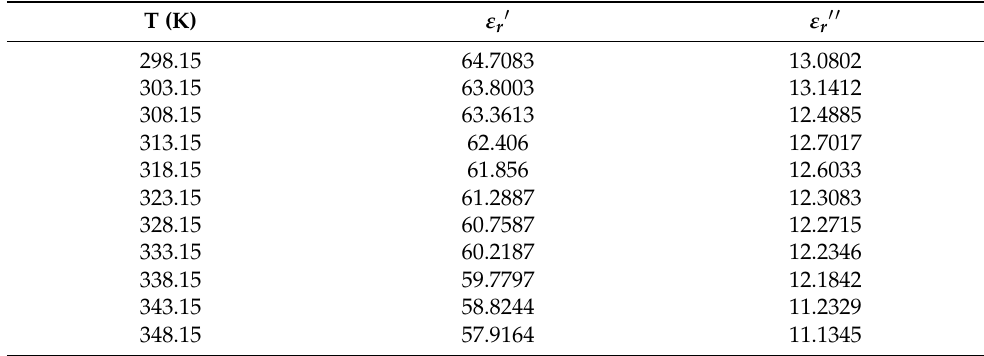
Table 2. The temperature-dependent dielectric properties of the milk (at 2.45